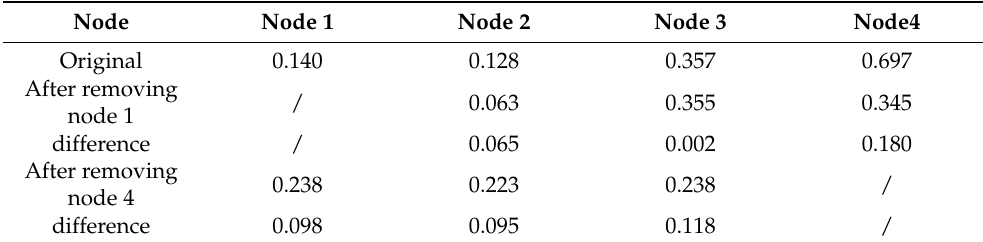
Table 2. The effect of deleting node 1 and node 4 on node